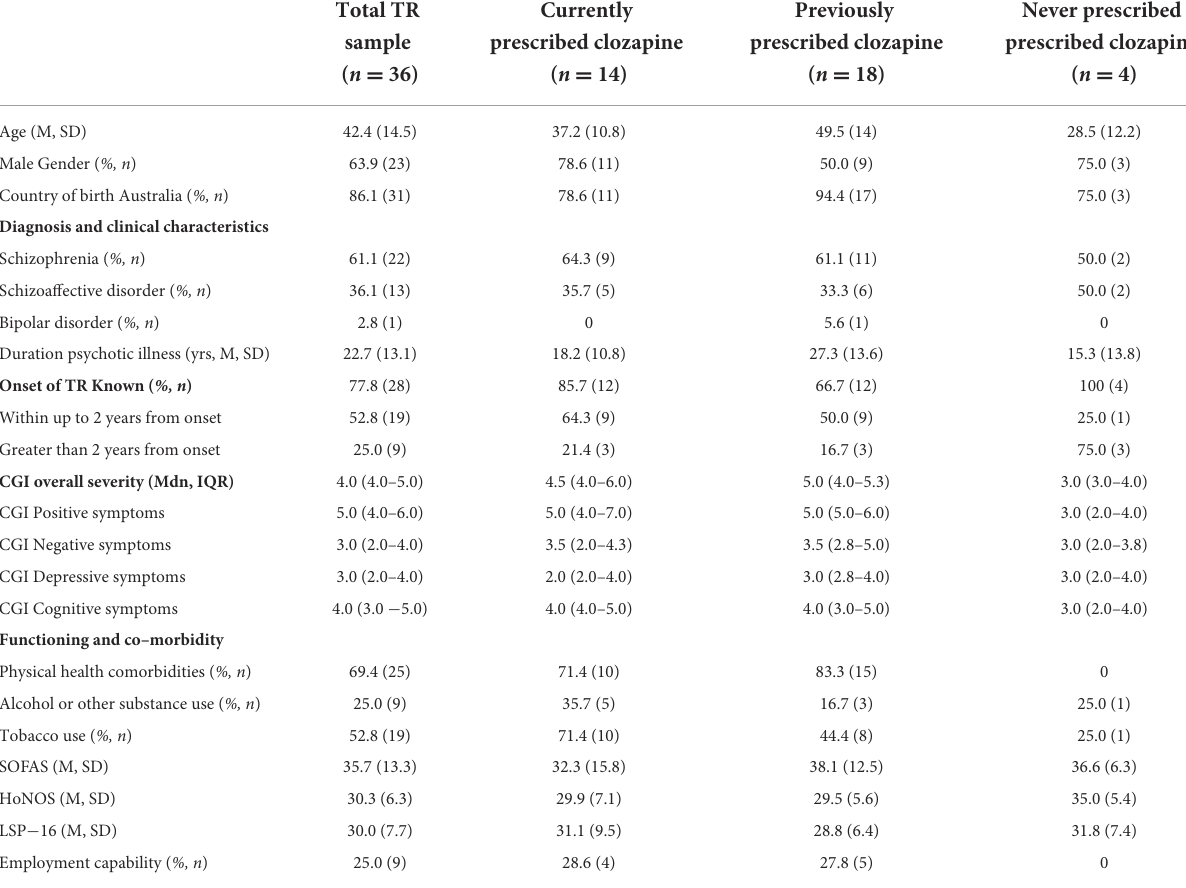
TABLE 1 Demographic and clinical characteristics in treatment-resistant (TR) sample.